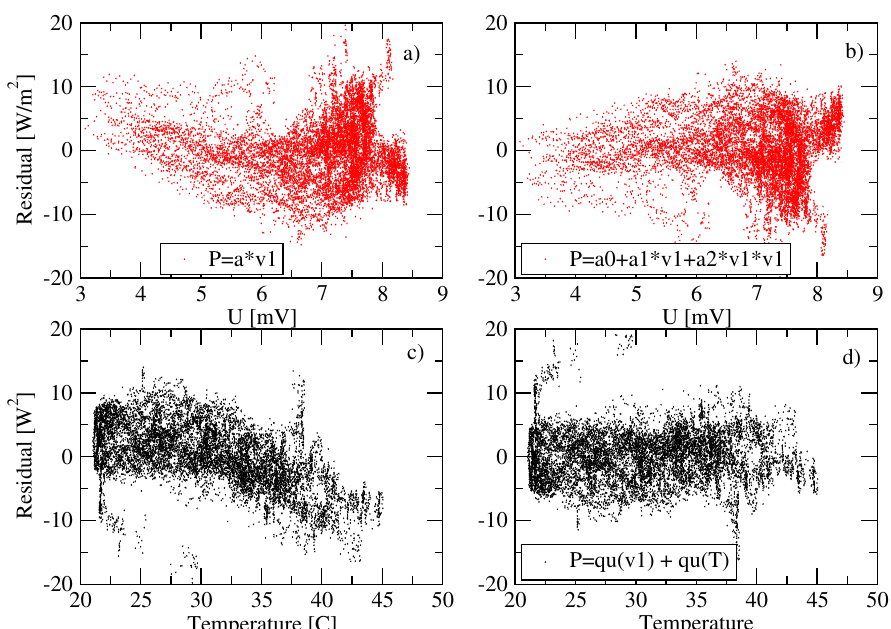
Figure 5. Panel ( a ) displays the difference between the data and the linear model for one of the data sets displayed in Figure 4. Panel ( b ) provides the residuum if instead of a model linear in the measured voltage a quadratic relationship is being assumed. The overall magnitude of the residuum in panel ( b ) is visibly smaller compared with panel ( a ). However, if the residuum is plotted as function of the device temperature (panel ( c )) again a non-stochastic behavior is evident. Instead, panel ( d ) displays a bivariate regression function i.e., a sum of a quadratic function of the voltage v 1 and a quadratic function of the temperature T appears to capture the data reasonably well. The resulting residuum shows no clear non-stochastic